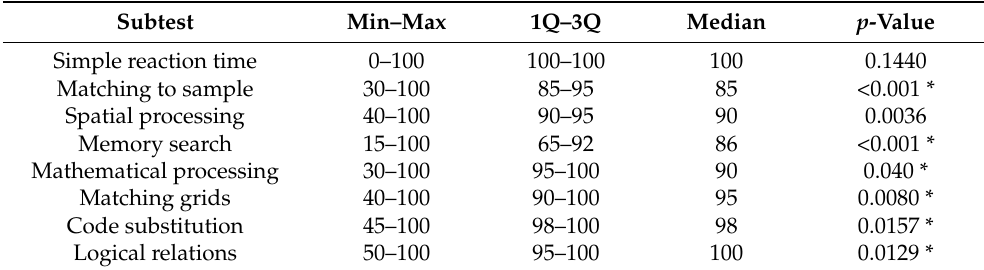
Table 5. Percentage of correct answers by aSLE patients in each subtest of the Ped-ANAM battery and comparison with healthy controls.